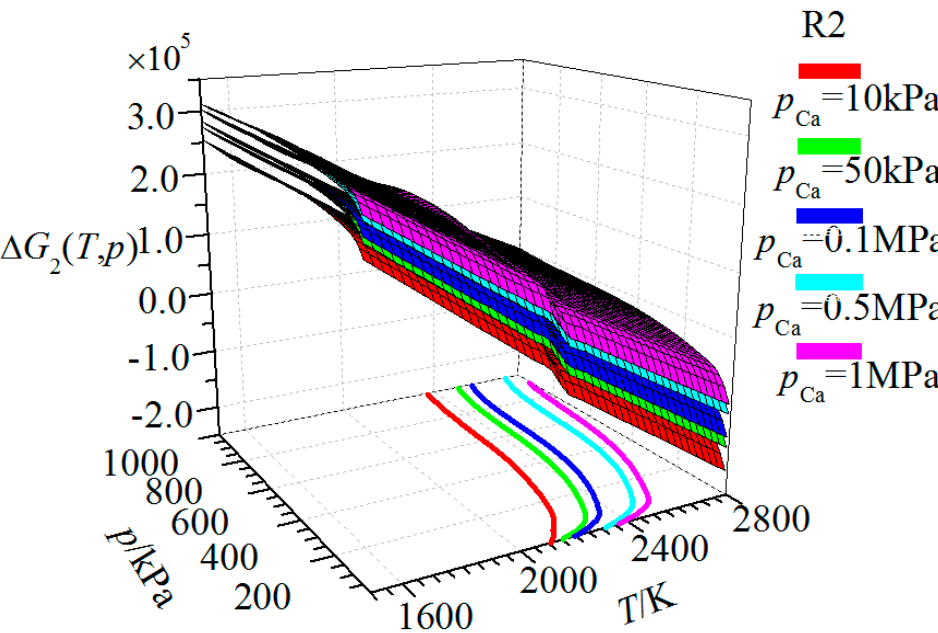
Figure 7. Gibbs energy dependence on temperature and Ca and CO partial pressure for reaction R2.